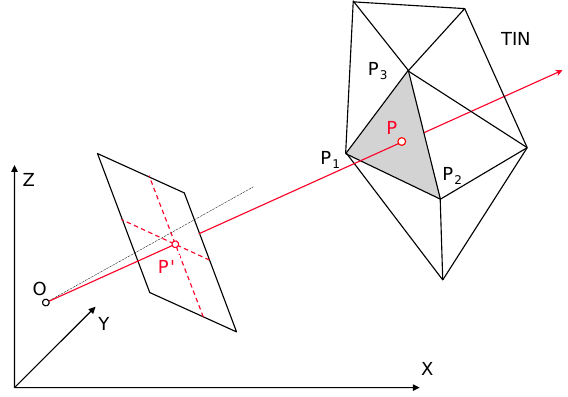
Figure 4. Principle of 3D monoplotting